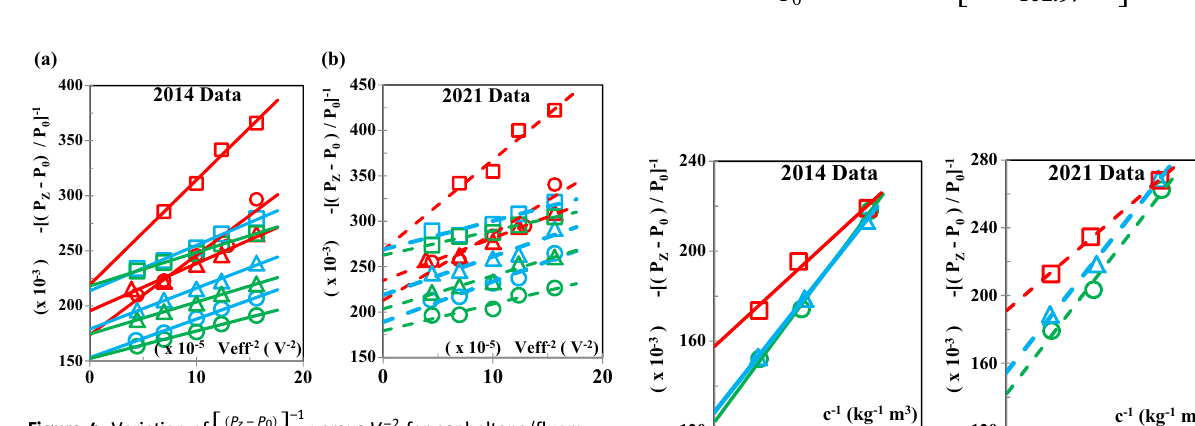
( −1 z 0 versus V eff −2 for asphaltene/ fl uoro - Figure 4: Variation of ⎡ ⎤ ⎣ ⎦ 0 benzene derivative samples at three distinct concentration levels. Here, A ∞−1 values equivalent to the junction points of the extrapolated best - fi t and the 0 eff−2 lines. ( The red lines represent 1,4 - di fl uorobenzene, the blue lines represent 1,3 - di fl uorobenzene, and the green lines represent